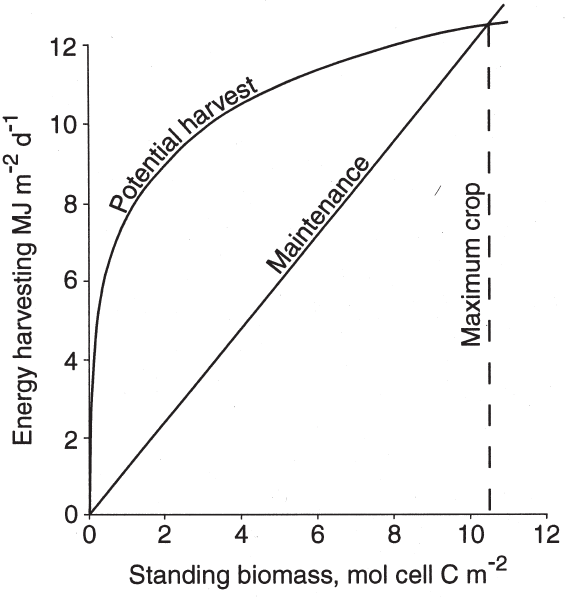
F IG . 1. – The Nielsen-Jørgensen representation of the potential exer- gy of a system, as the excess energy harvesting capacity relative to the biomass maintenance costs. The quantification is based on the physiology of the alga Chlorella (Reynolds